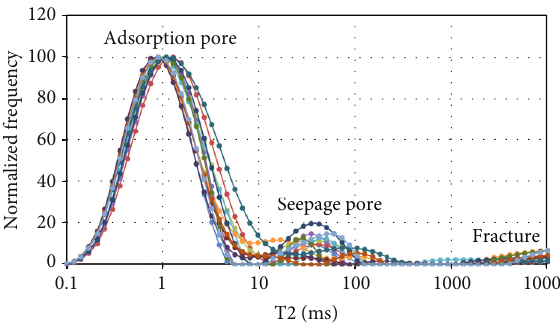
Figure 3: T2 spectrum characteristics of No. 3 coal in SZ